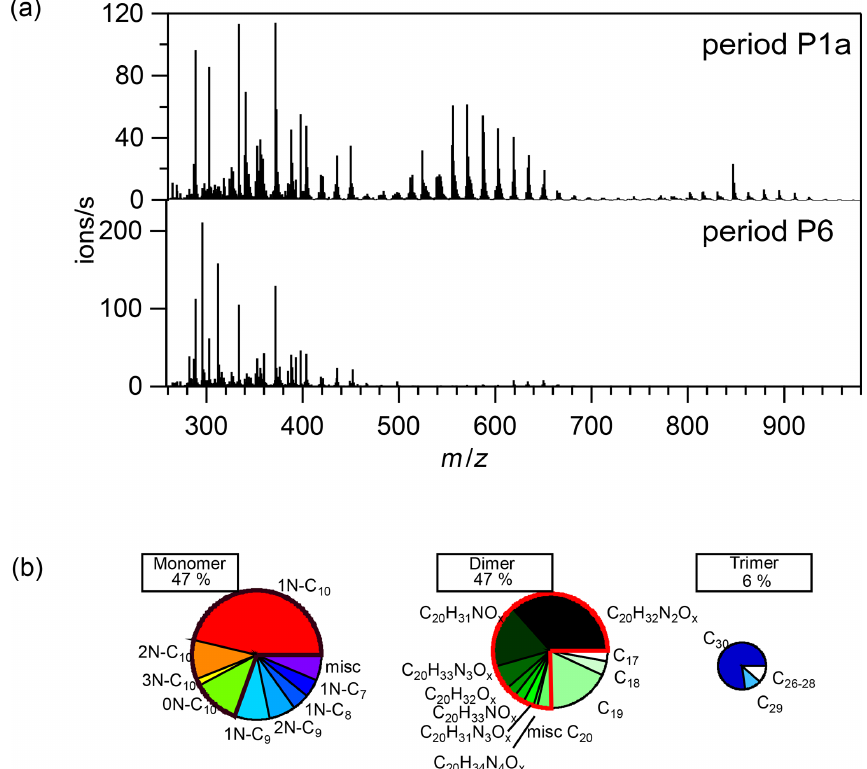
Figure 2. (a) Average mass spectra of the first 10min reaction time after the first addition of limonene (period P1a, upper panel) and the last limonene addition period till particles reached maximum mass concentration (period P6, lower panel). (b) Pie charts (from left to right: rainbow, green, and blue colors) representing the relative contributions of identified families to HOM monomers, dimers, and trimers, respectively, during the P1a period. The area of each pie is in proportion to their concentrations during the P1a